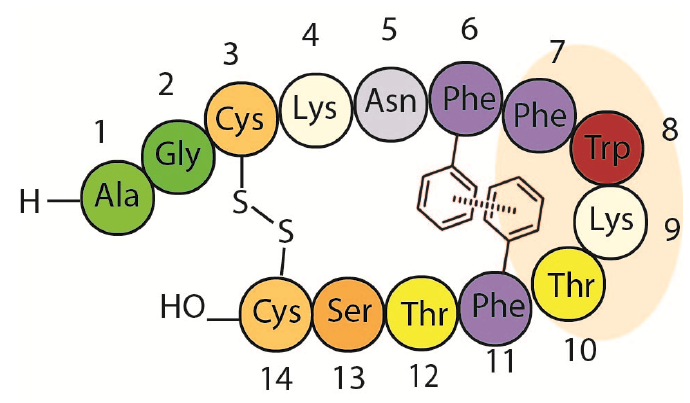
Figure 3. Proposed Phe6-Phe11 aromatic stabilizing